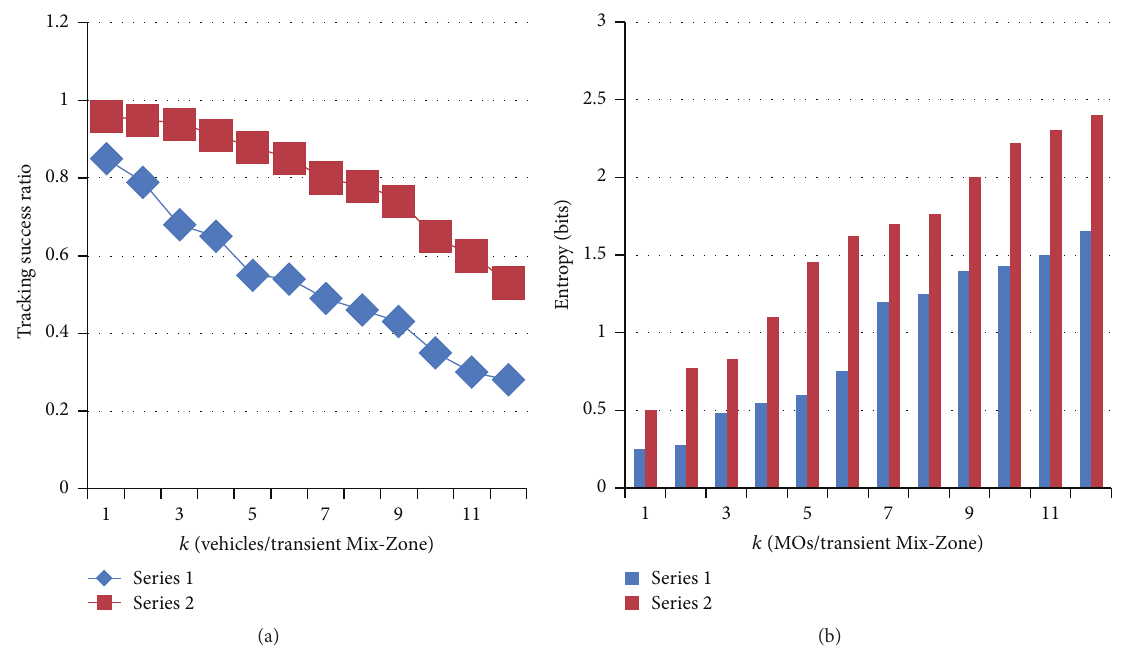
Figure 6: Analysis of the vehicular data. (a) Attacker’s success probability. (b) Privacy levels achieved with increasing anonymity (here Series 1 depicts light traffic flow and Series 2 depicts heavy traffic